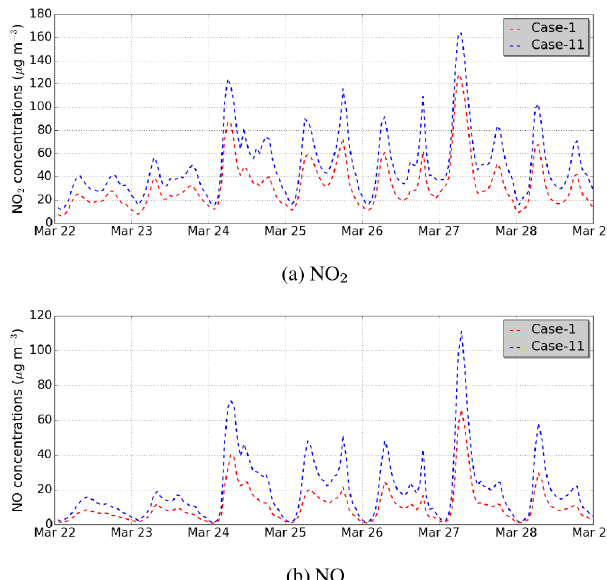
Figure 12. Comparison of the Case-1 hourly concentrations to those in the sensitivity simulation Case-11 (which modifies the build- ing aspect ratio over the whole simulation domain): (a) NO 2 and (b)